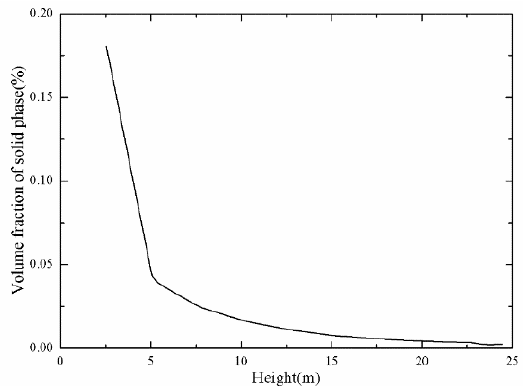
Figure 9. Distribution of solid volume fraction along the height.